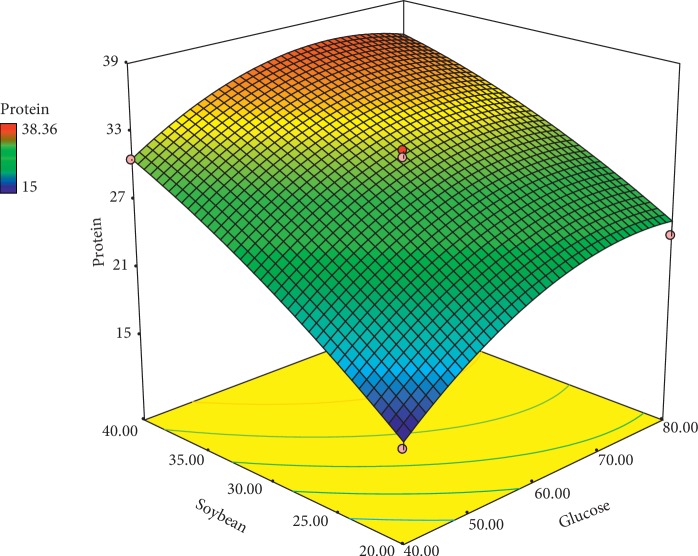
Response surface curve for protein production by M. fluvialis.